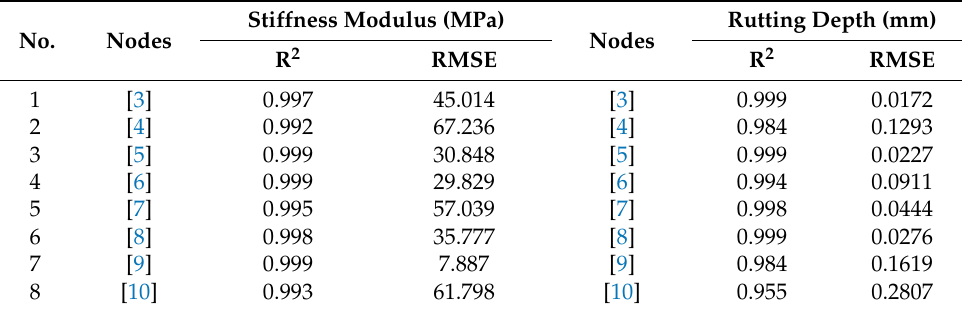
Figure 16. ANN topology for the rutting response of the modified asphalt mix. Table 9. Optimized ANN architecture for input and output factors